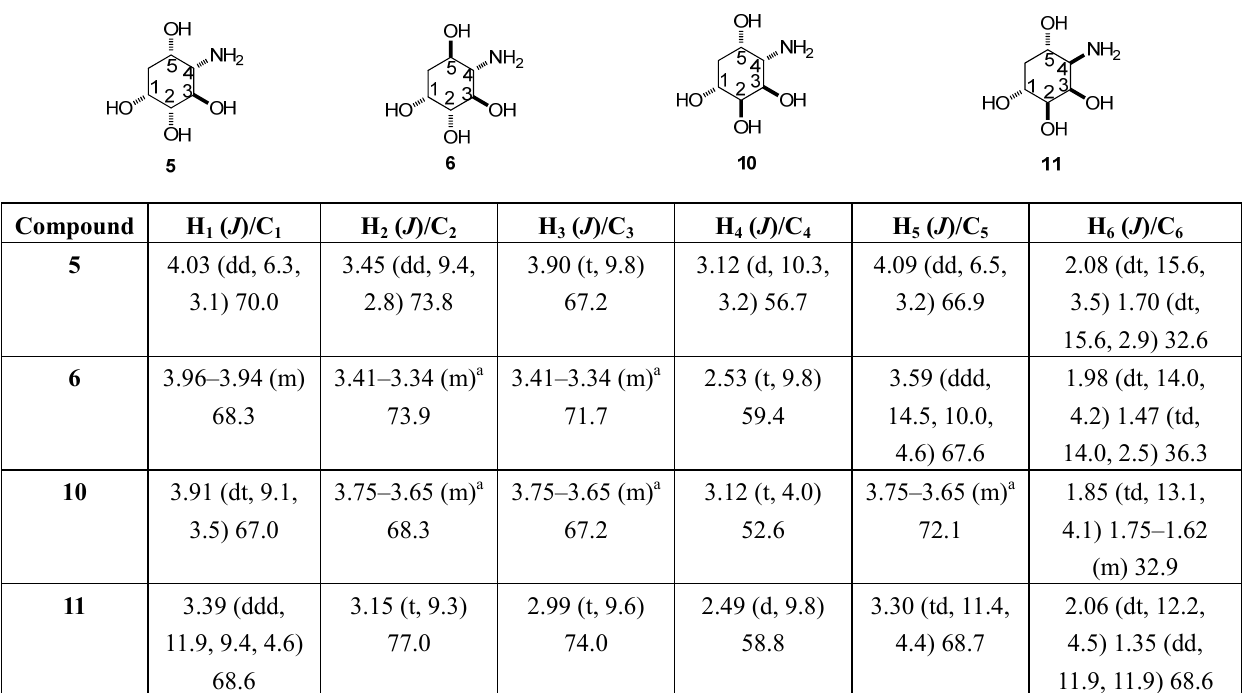
Table 2. Selected 1 H (600 MHz) and 13 C (150 MHz) NMR data for 5 , 6 , 10 , and 11 in D